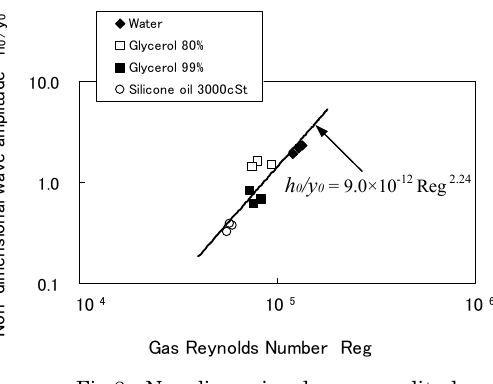
Fig.8 Non-dimensional wave amplitude